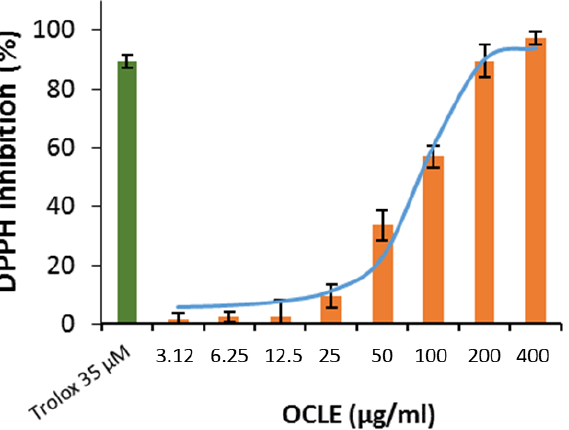
Figure 6. Scavenger activity against DPPH of O. crenata leaf extract (OCLE). The results are expressed as a percentage of the decrease in absorbance at λ = 517 nm compared to the standard Trolox. Each value represents the mean ± SD of three experimental measurements.